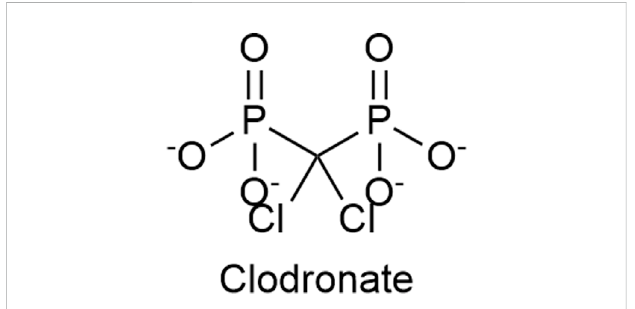
FIGURE 7 The structure of Clodronate, a fi rst generation non-nitrogen- containing bisphosphonate, which is an inhibitor of the vesicular nucleotide transporter